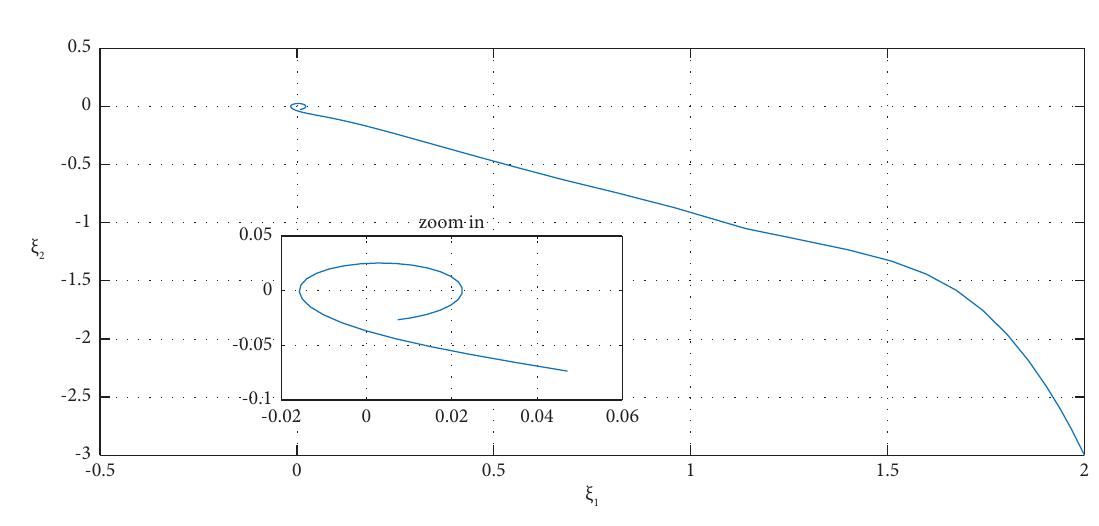
Figure 1: Evolution of system states ξ